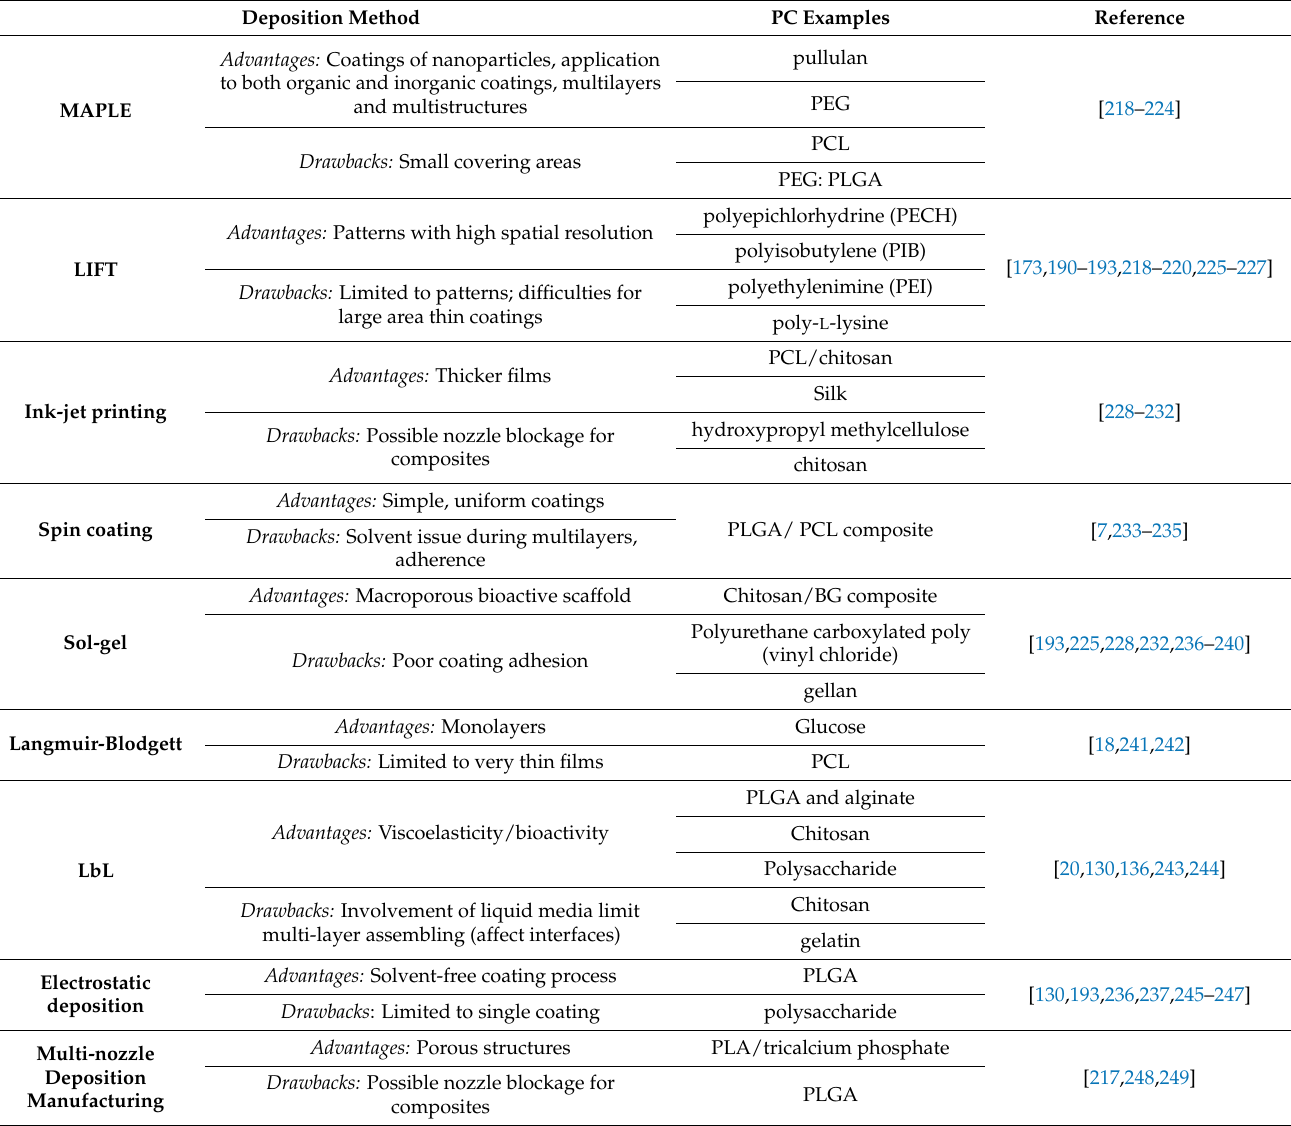
Table 4. Widely used deposition methods for polymeric thin films employed on the degradation